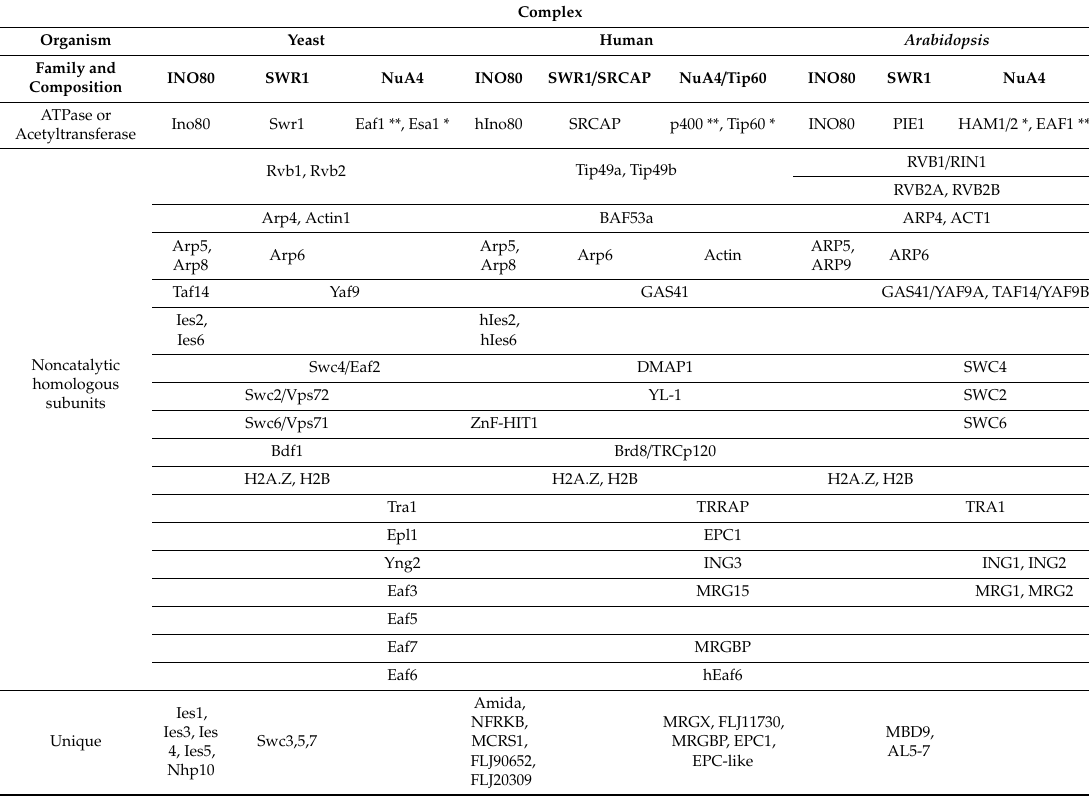
Table 1. Compositions of INO80, SWR1 and NuA4 Complexes in